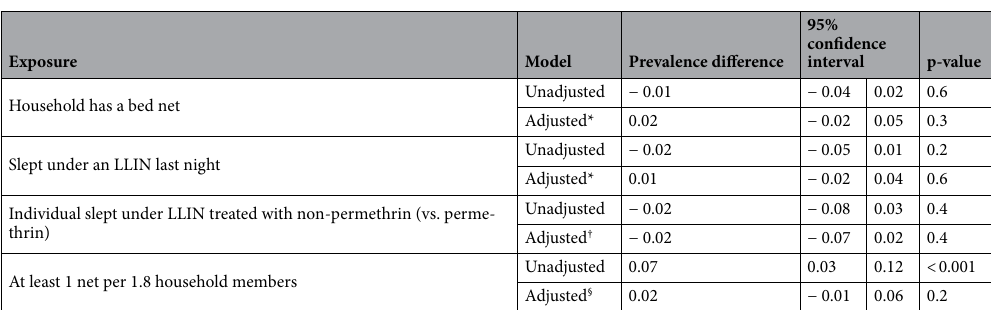
Table 3. Multivariate associations between bed net associated risk factors and P. falciparum prevalence using weighted survey data. LLIN long-lasting insecticide treated net. *Models adjusted for age, sex, wealth, and household size. † Model adjusted for age, sex, and wealth. § Model adjusted for wealth and district.